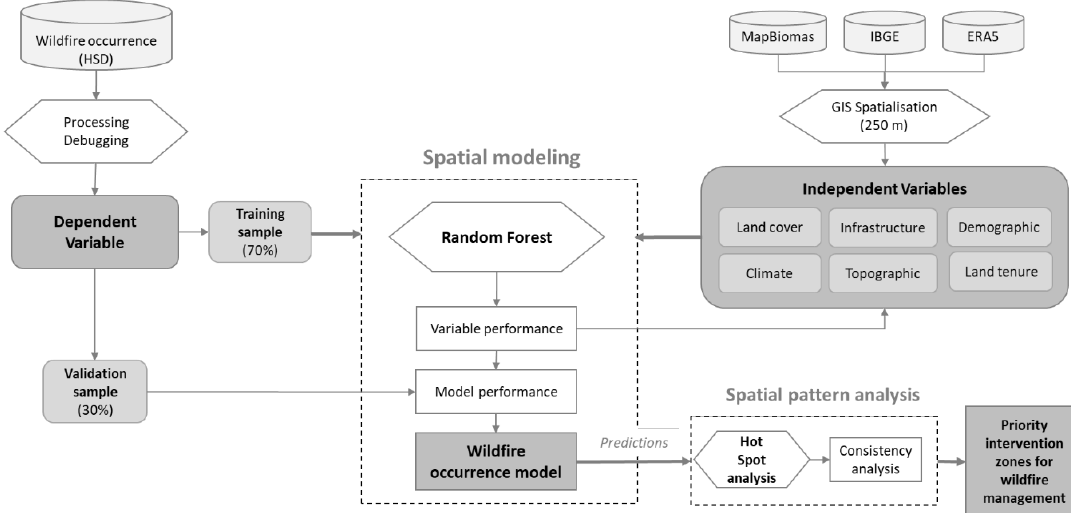
Figure 3. The general workflow for modeling and mapping the probability of wildfire occurrence in the Brazilian savanna.